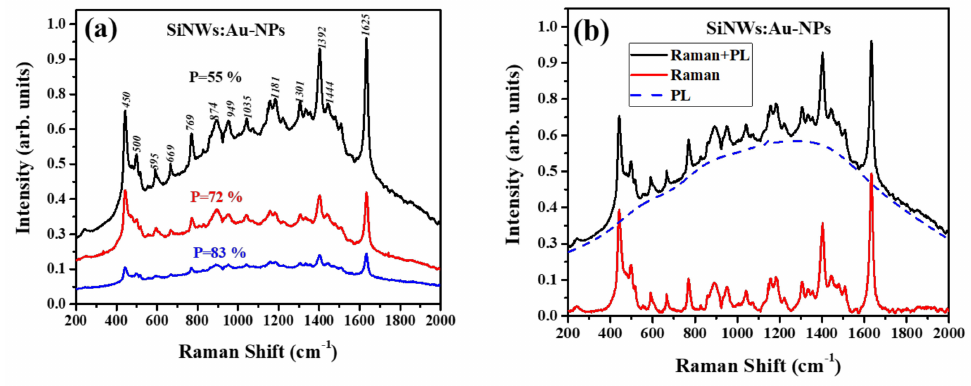
Figure 6. ( a ) Raman and PL spectra measured for SiNWs:Au-NPs arrays with porosity P = 55% (black line), 72% (red line), and 83% (blue line) after deposition of MB molecules (10 − 6 M); ( b ) the same spectrum for the sample with porosity 55% (black line) and its deconvolution by SERS (red line) and PL (dashed blue line)